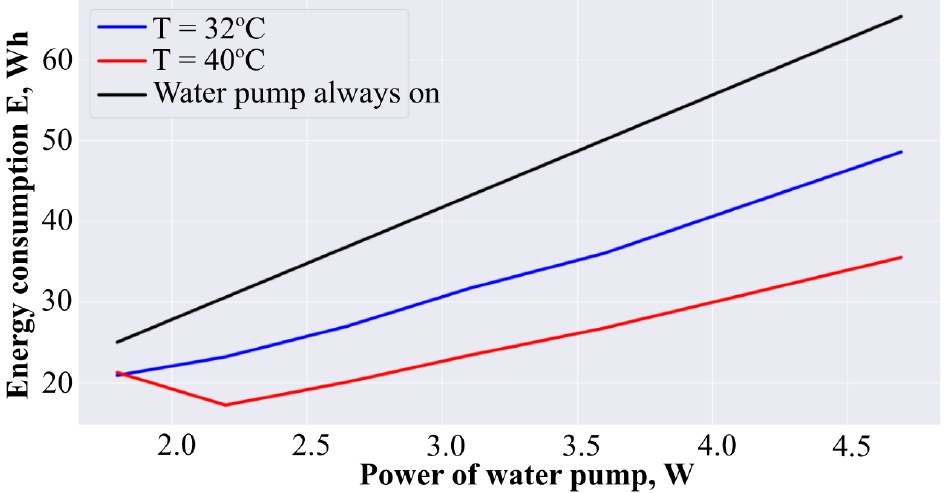
Figure 18. Power consumption of the water pump in three operating